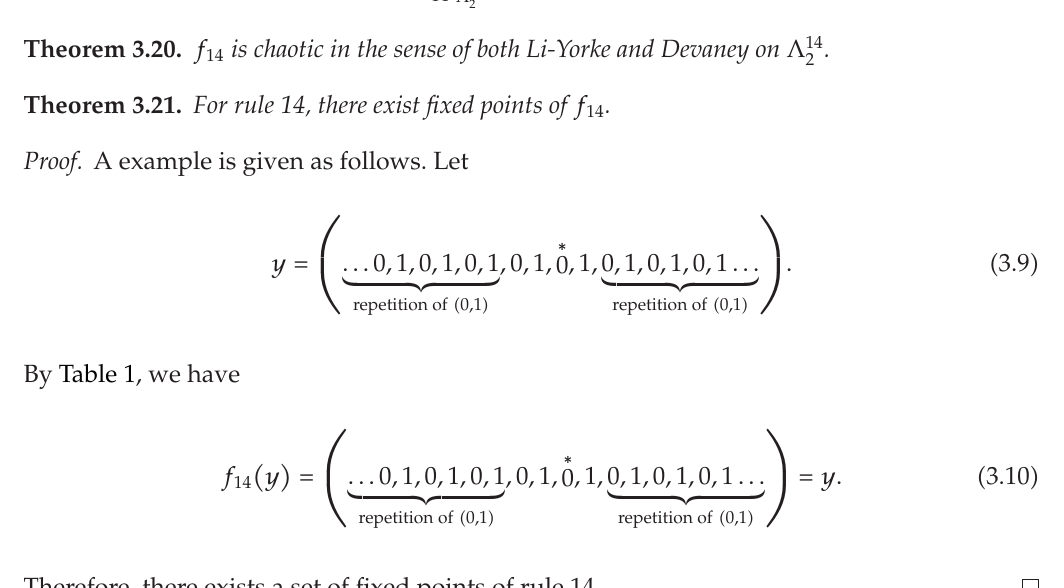
of the matrix B 2 2